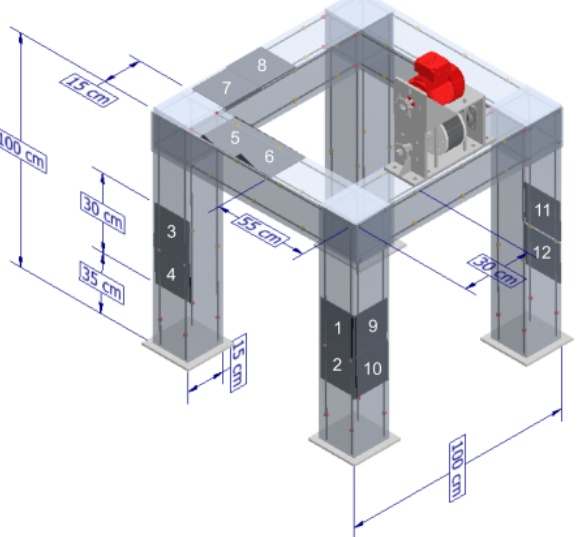
Figure 6. Location of artificial positive damages. Yellow dots represent strain sensors and red dots temperature